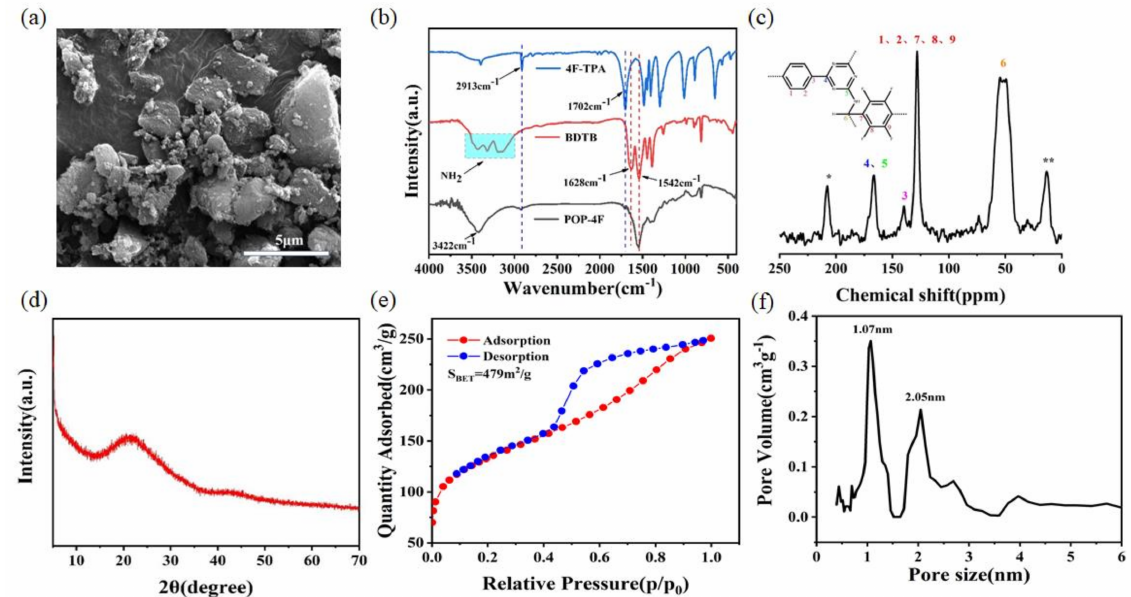
Figure 2. Characterization of POP-4F. ( a ) SEM; ( b )FT-IR; ( c ) solid-state 13C NMR; ( d ) XRD; ( e ) N 2 adsorption-desorption isotherms; ( f ) Pore size